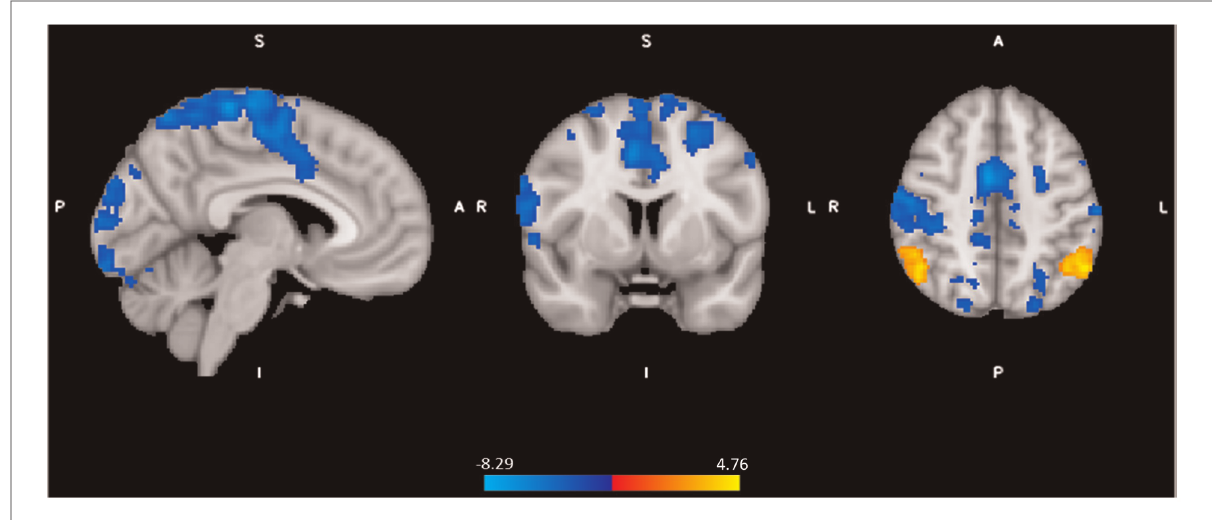
FIGURE 4 Signi fi cant neural responses to thermal noxious stimuli, resulting from a whole-brain analysis of the spinal session versus the control session (spin (post − pre) - control (post − pre) ), main effect of intervention. Red-yellow clusters correspond to higher BOLD response during spinal anesthesia compared to control, blue clusters correspond to a lower BOLD response during spinal anesthesia, p <0.05 cluster corrected. Images are Z-statistics thresholded at (-)2.3, overlaid on the MNI-152 standard brain. A=Anterior, I=Inferior, L=Left, P=posterior, S=Superior, R=Right. The signi fi cant clusters are described in detail in Table 3 .